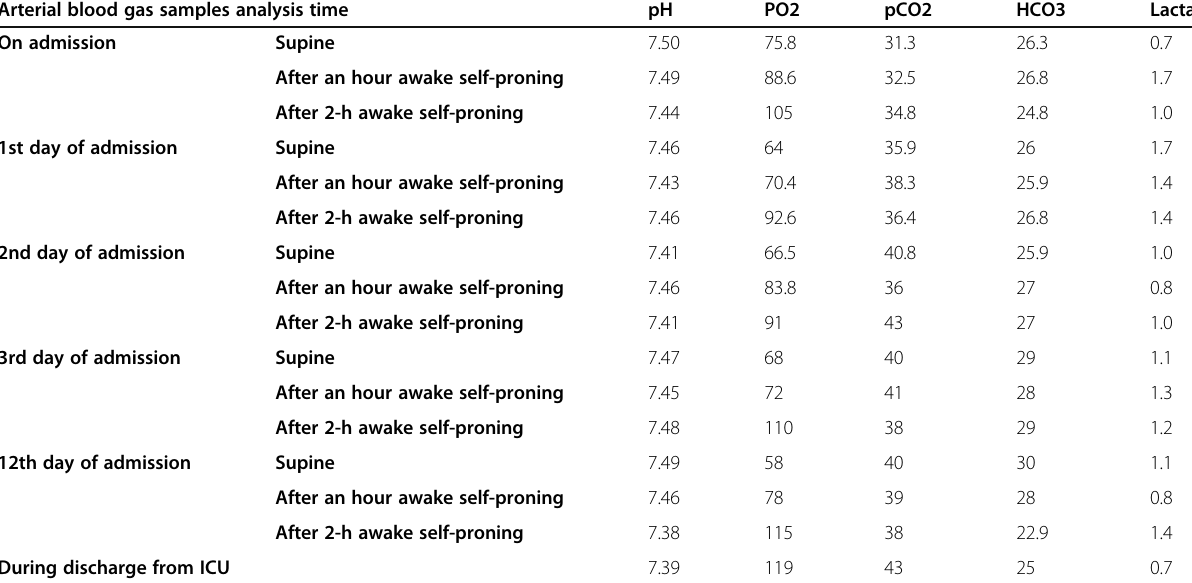
Table 1 Intermittent arterial blood gas analysis during ICU stay Arterial blood gas samples analysis